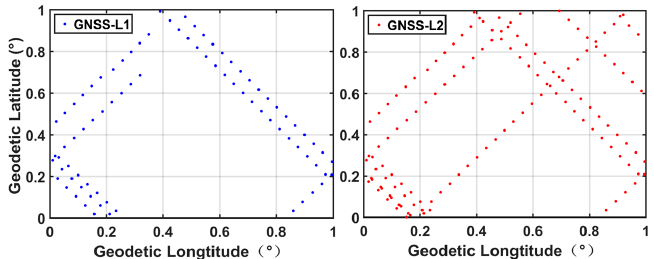
Figure 5. Reflection ground locations during 48 h period for a 1° × 1° bin at GPS L1 frequency ( left ) and GPS L2 frequency ( right ) when eight GNSS-R LEO satellites and 119 GNSS satellites are used.